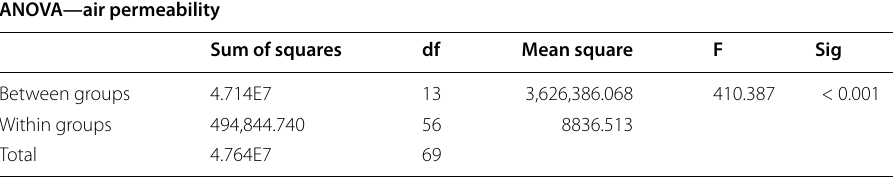
Table 7 The one-way ANOVA test of air permeability ANOVA—air permeability Sum of squares df Mean square Between